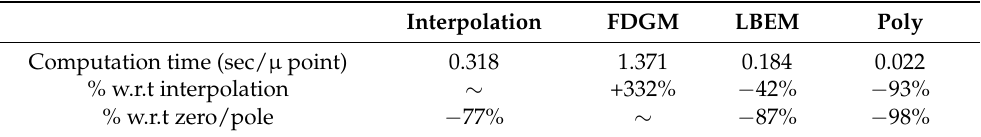
Table 5. Computation times of the